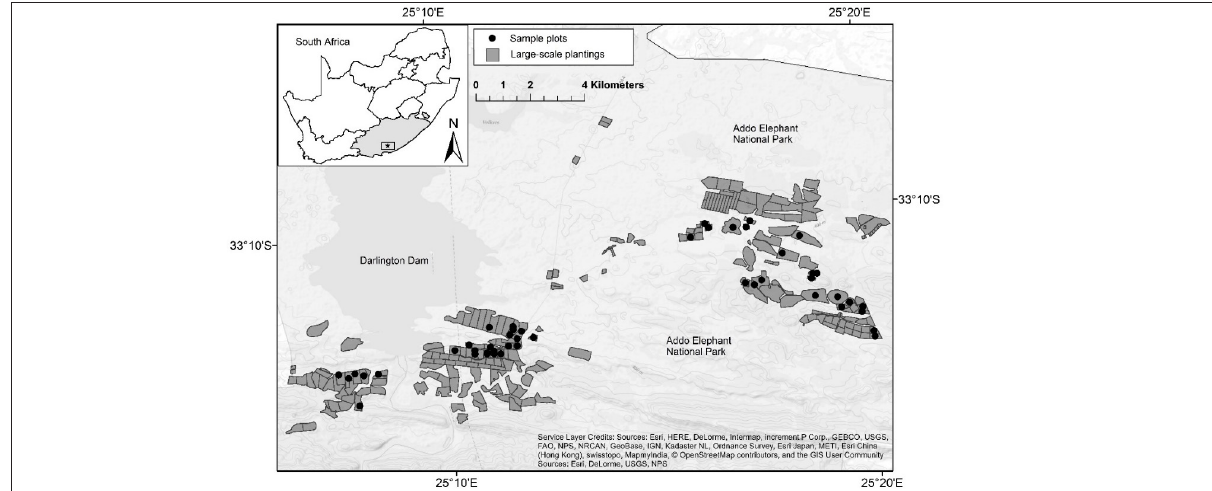
Figure 1: Sample plots and large-scale plantings in Addo Elephant National Park in the Eastern Cape, South Africa.